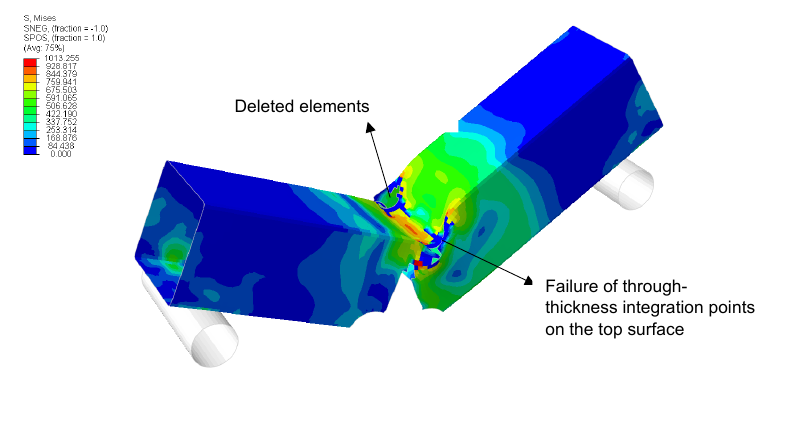
Figure 15. Equivalent stress plot of the post-mortem test model as predicted by FEA using a constant failure